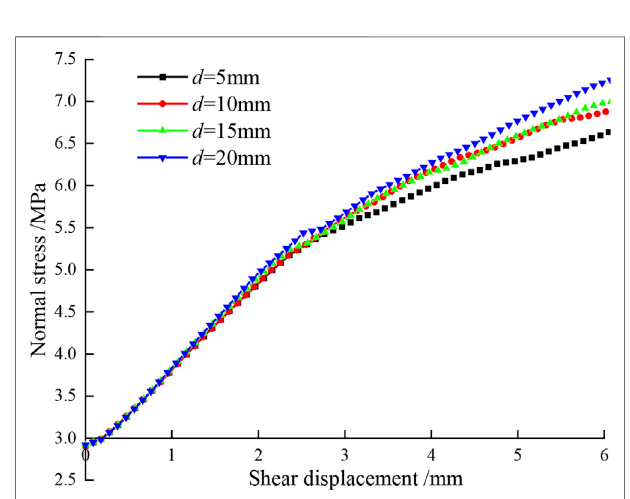
FIGURE 12 | Shear displacement relation and SRI of J3 with different spacings.